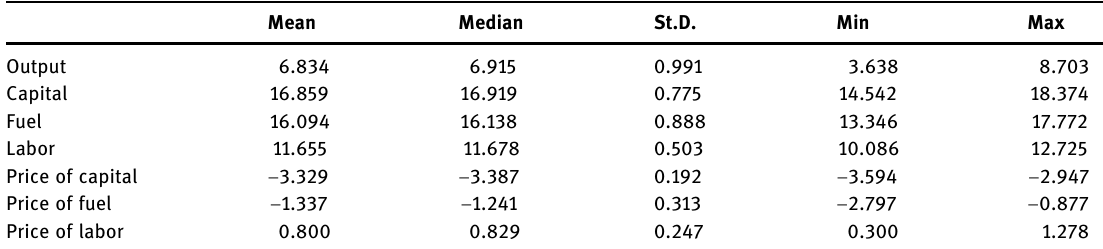
Table 2: Descriptive statistics for electricity generation data